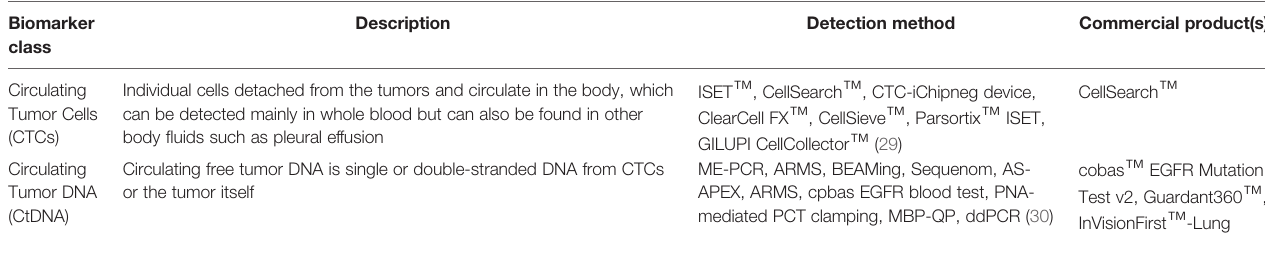
TABLE 1 | Circulating biomarker candidates for NSCLC